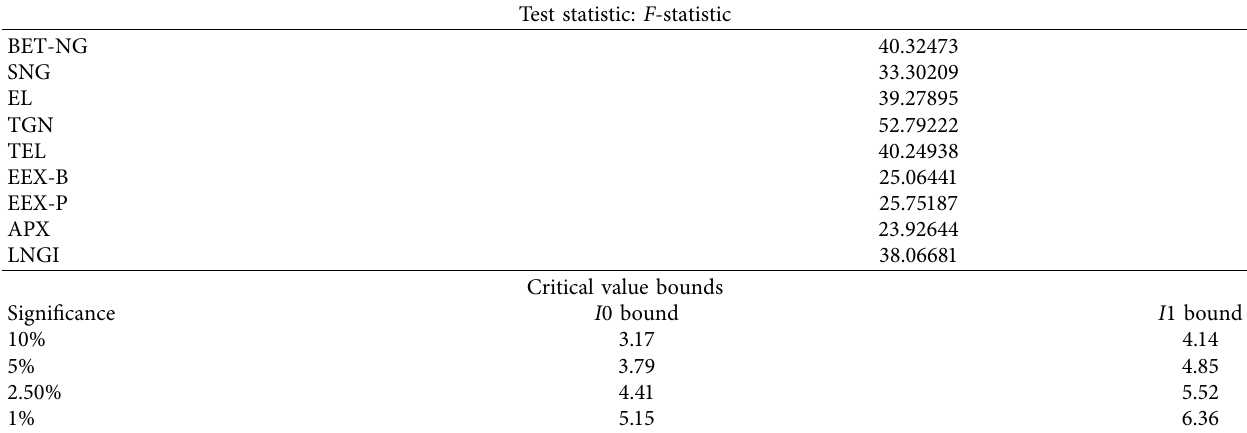
Table 8: The results of the ARDL bounds test for the model environment and COVID-19. Test statistic: F